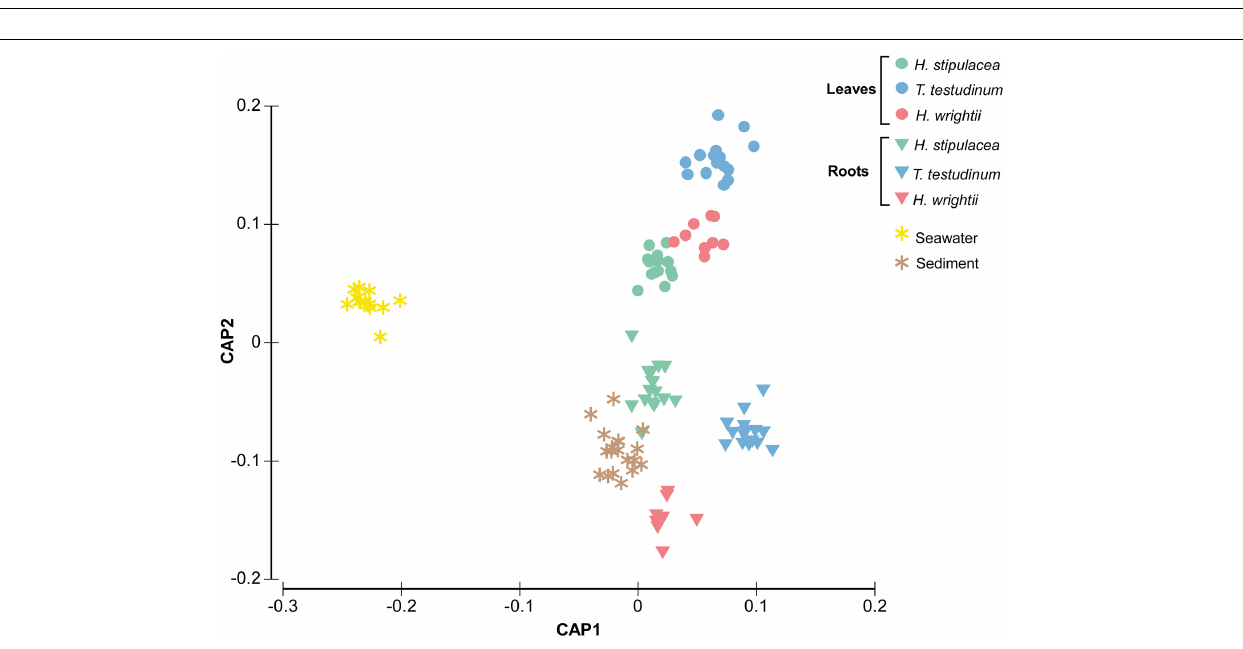
seagrasses: H. wrightii (36) and T. testudinum (33) ( Figure 5